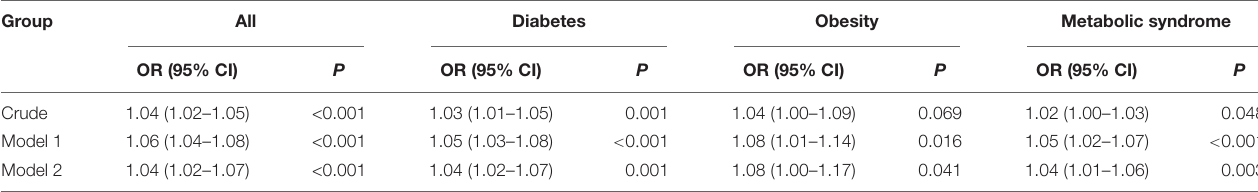
TABLE 3 | Crude and adjusted models used to assess the association between the serum FABP4 and liver steatosis.